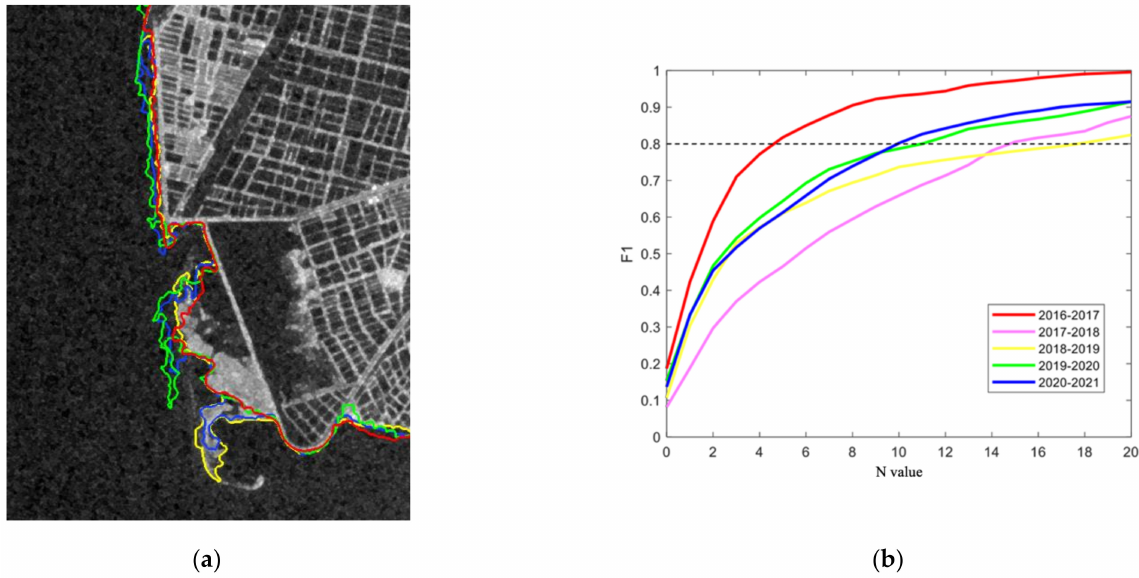
Figure 10. Shoreline detection performance of the proposed method from 2016 to 2021. ( a ) The detection results of 2016 shown in red, 2018 in green, 2020 in blue, and 2021 in yellow. SAR imagery is 2021. ( b ) F1-measure curves of two consecutive years. ( a ) Detection results of different years.; ( b ) F1-measure